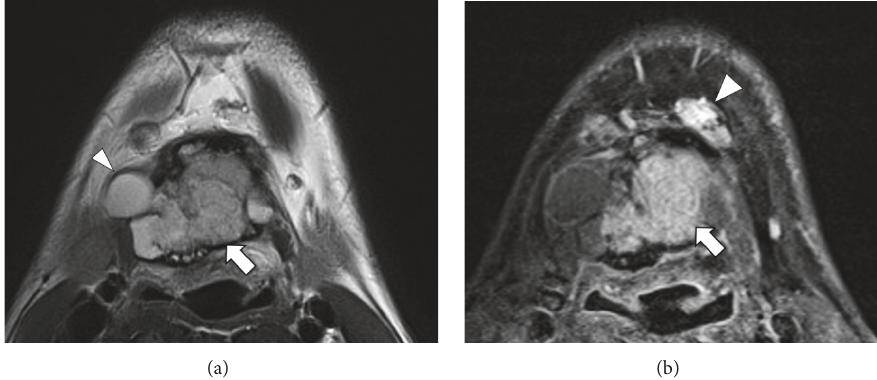
Figure 2: MRI of the neck. (a) T2-weighted image at the level of the hyoid bone shows intermediate signal intensity corresponding to the solid component (arrow) and high signal intensity corresponding to the cystic component (arrowhead). (b) Contrast-enhanced fat-suppressed T1- weighted image at the same level as (a) shows marked enhancement of the solid component (arrow). Left submental lymphadenopathy is also seen